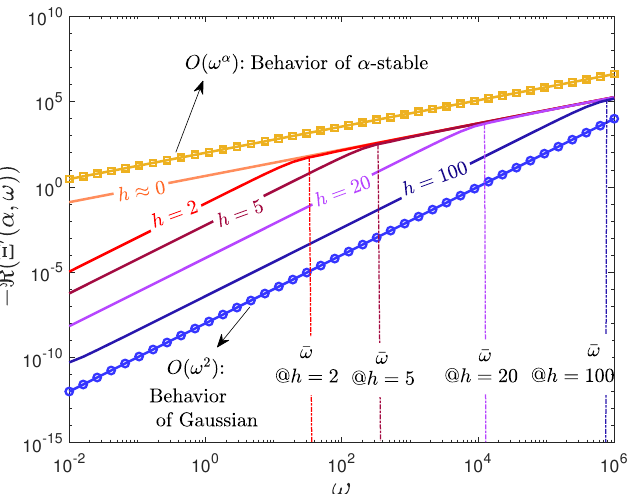
Figure 10. Real part of the Ξ ( α , ω ) (cid:48) vs. ω for 2 b = 2.6 and λ = 1 m − 2 , with a single isotropic antenna for different heights of the array. The two guidelines are parallel to ω α and ω 2 . For large heights, Ξ (cid:48) ( α , ω ) vs. ω behaves as ω 2 , and for very small heights it behaves as ω α , while for medium heights, it has two different slopes based on ω .